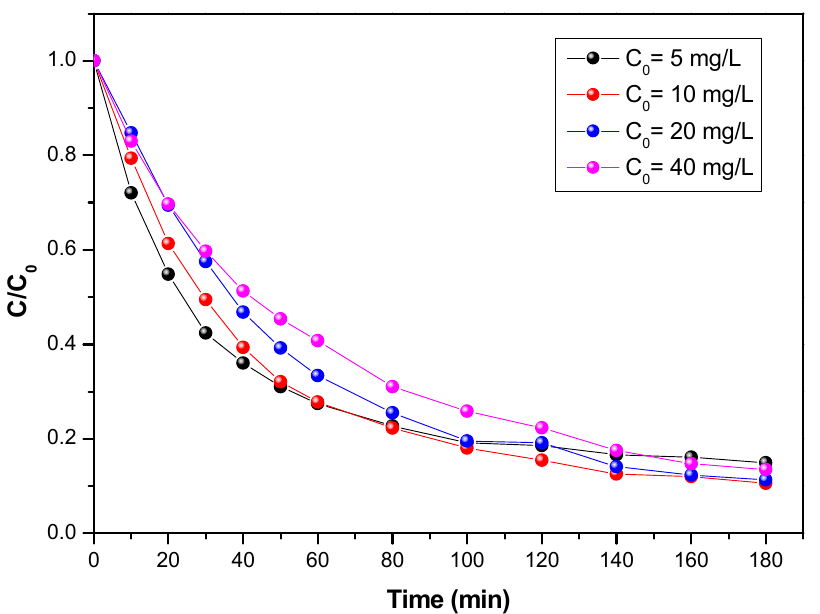
Figure 3. Evolution of the concentration of flumequine during its photocatalytic degradation versus time for four initial concentrations at a flow rate of 29 L/h and a UV of 38 W/m 2